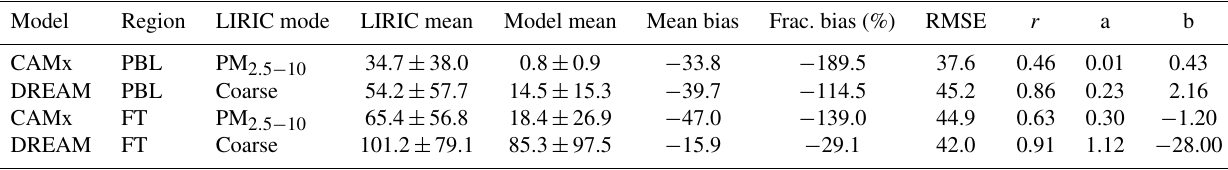
Table 6. Dust integrated mass metrics. Metrics for the two models in two atmospheric regions are provided. The region below the boundary layer is symbolized as the PBL, while the region above it, in the free troposphere, is defined as FT. A total of 6 out of 22 cases are included in the category “dust”. The mean, standard deviation, mean bias and root mean square error values are in mgm − 2 units. Pearson’s correlation coefficient ( r ) and the least square fit slope (a) and intercept (b) values are also calculated. Model Region LIRIC mode LIRIC mean Model mean Mean bias Frac. bias (%) RMSE